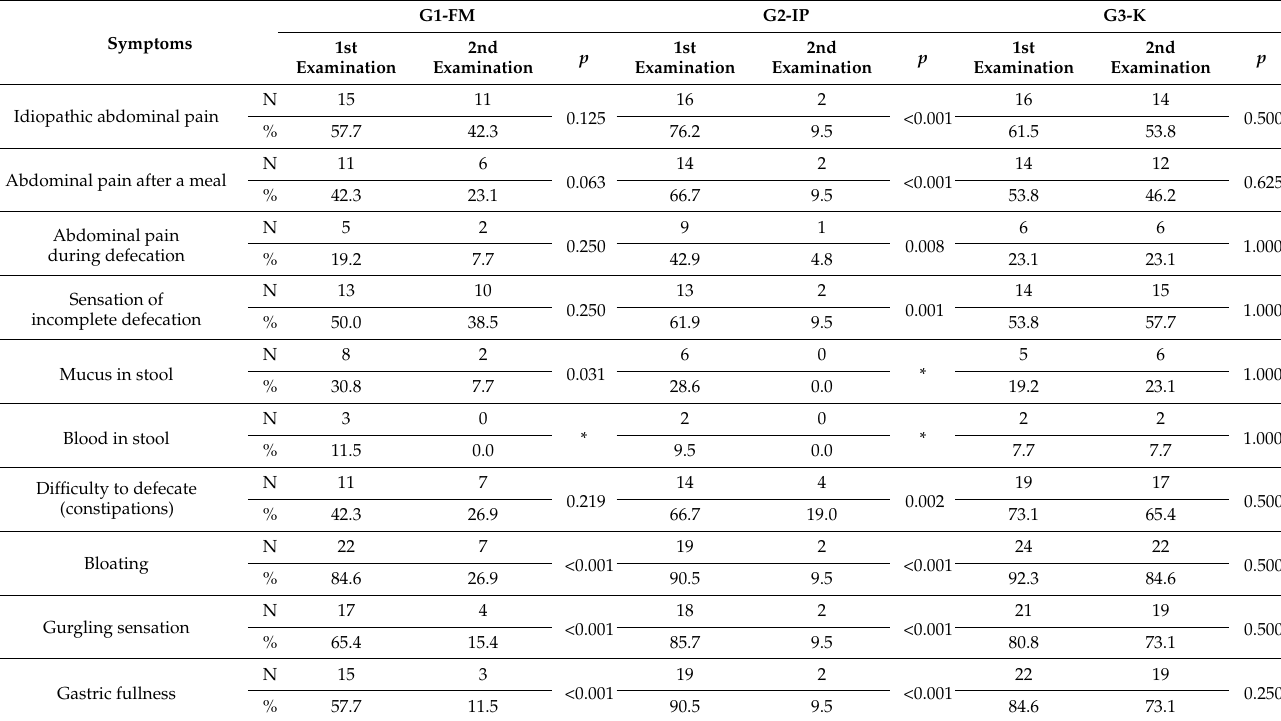
Table 2. Frequency of IBS symptoms in studied patients before and after dietary treatment.